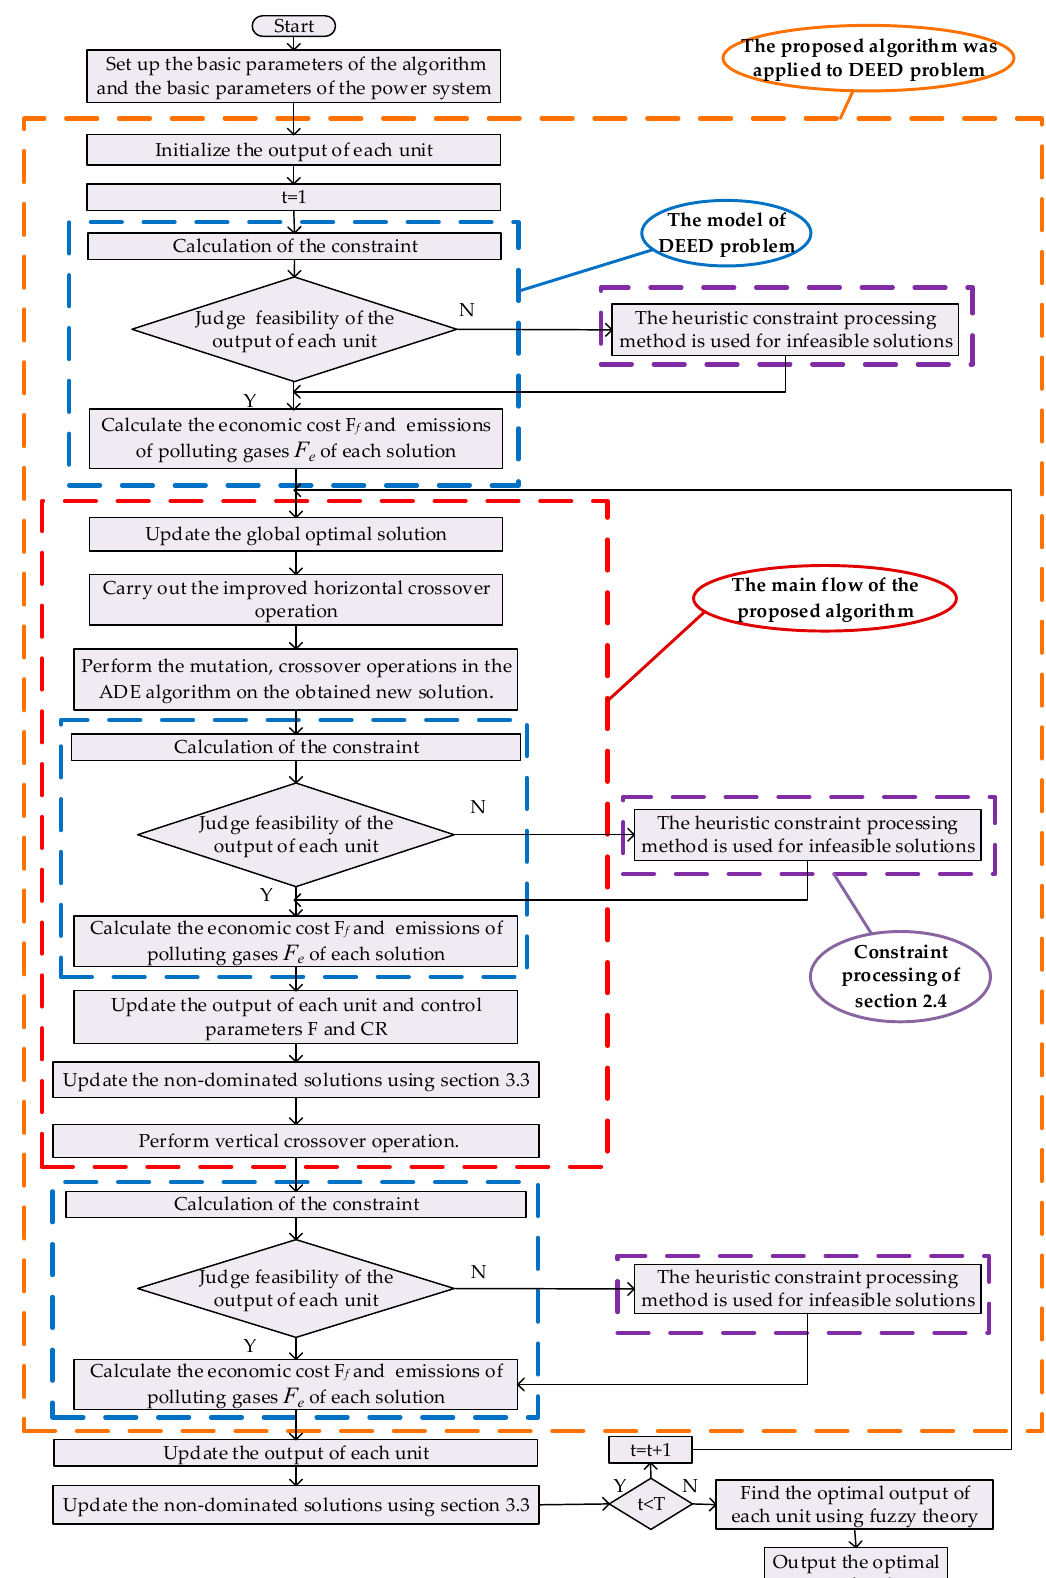
Figure 2. The flow chart of multi-objective differential evolution and crisscross optimization (MODECSO) algorithm for solving dynamic economic/emission dispatch (DEED) problem.